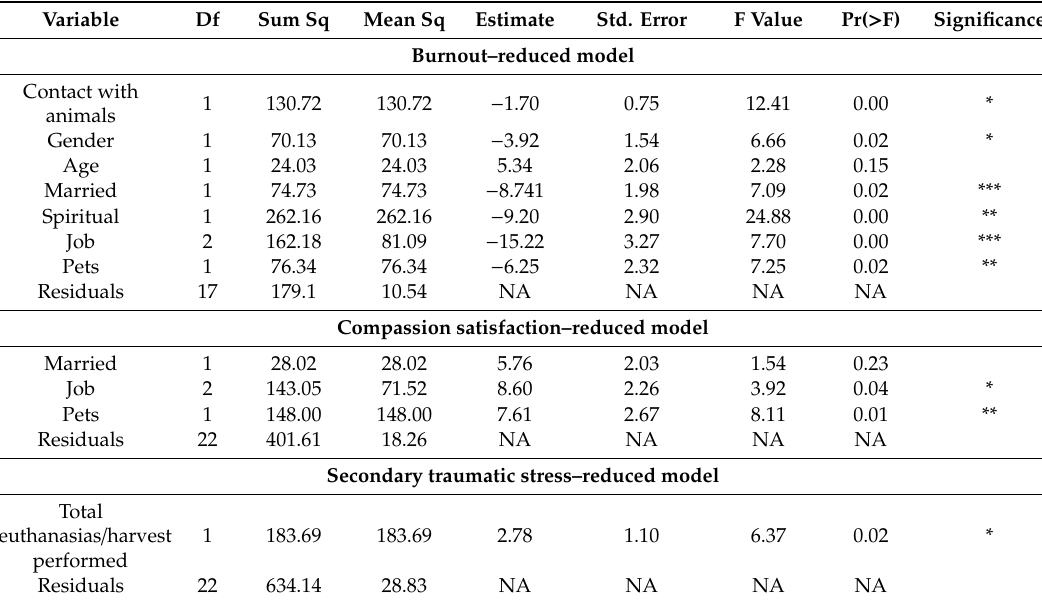
* Note. Higher moral injury scores indicate lower moral injury. Table 4. Shows the reduced linear model output for Experiment